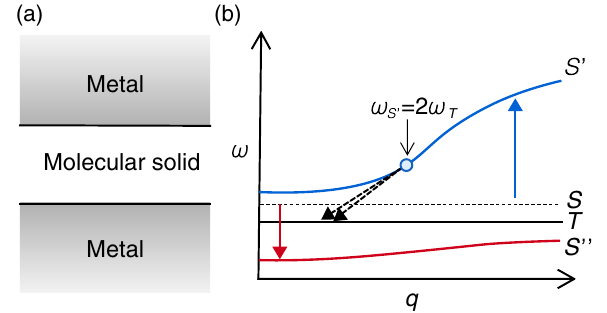
FIG. 13. Possible applications of the cavity setting to molecular and excitonic systems. (a) Schematic figure illustrating the proposed setup, in which molecular solids or assembled mole- cules interact with light modes confined between metal mirrors. (b) Schematic figure illustrating applications of the elementary excitations in the cavity setting to an organic light-emitting device and a photon-exciton conversion. The black horizontal solid (dotted) line denoted as T ( S ) indicates a bare nondispersive triplet (singlet) energy of a molecular state or an electron-hole pair. Only the singlet state S couples to confined light modes, resulting in the split into the multiple branches of the in-plane dispersions. A lower dispersion (red solid curve denoted as S 00 ) can potentially be applied to enhance the efficiency of organic light-emitting devices. Tuning the in-plane momentum q or the thickness of the layer, a higher dispersion (blue solid curve denoted as S 0 ) can be used to realize the resonance condition 2 ω ω , leading to a conversion of a photon into a pair of S 0 ¼ T triplet excitons as denoted by two dashed black